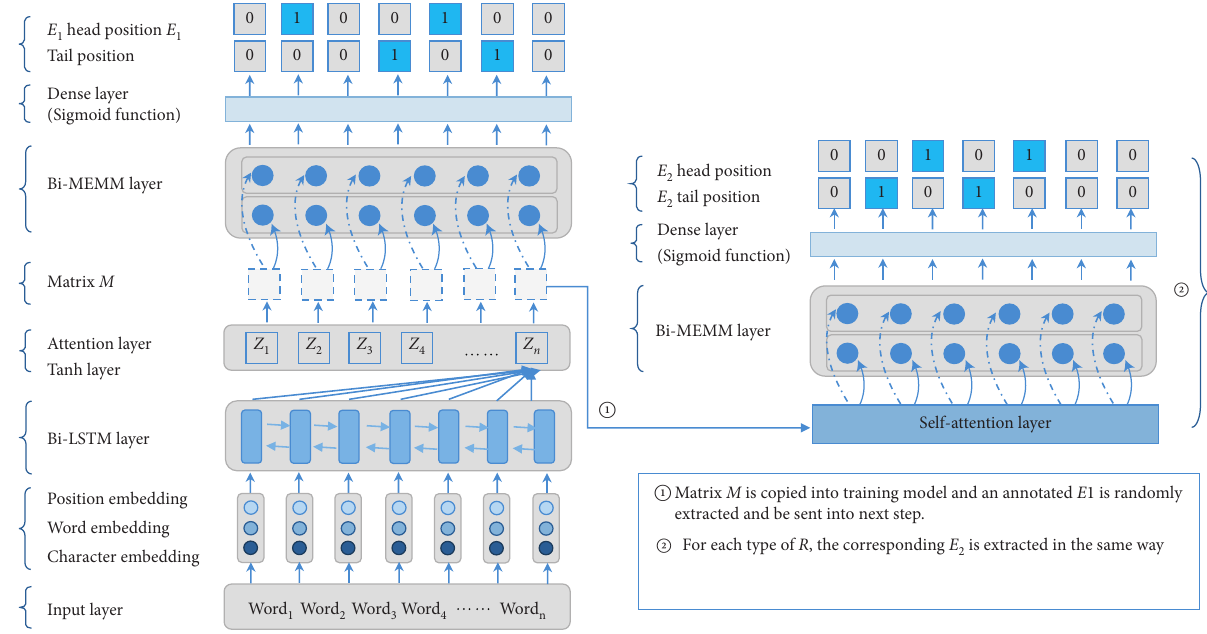
Figure 1: The structure of